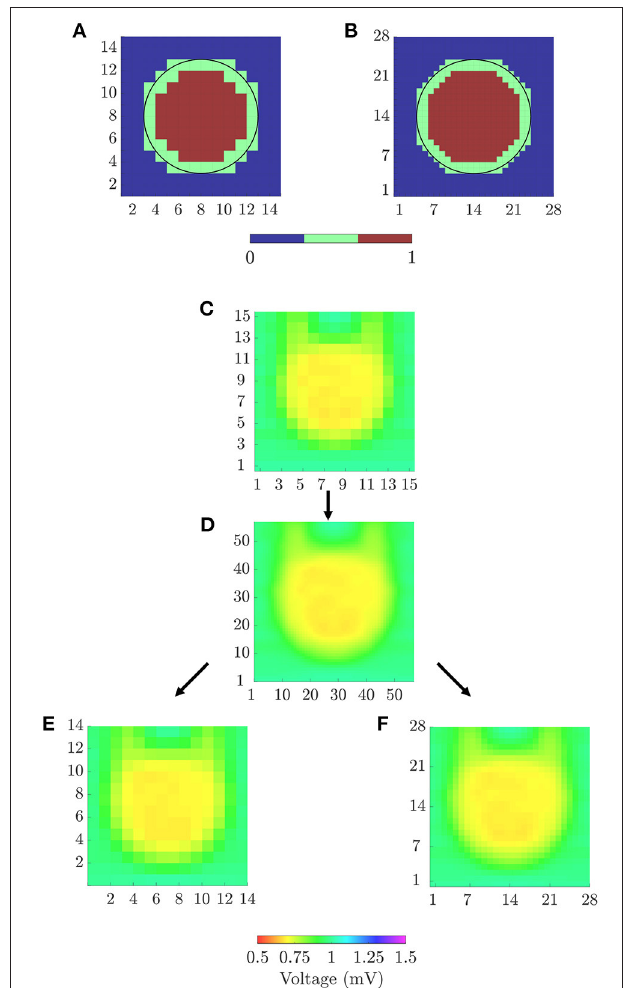
FIGURE 4 | (A) 14 14 and (B) 28 28 ground-truth masks for fibrosis × × detection, for square and triangular cliques, respectively. (C) 15 peak-to-peak amplitudes map from u-EGMs and (D) 57